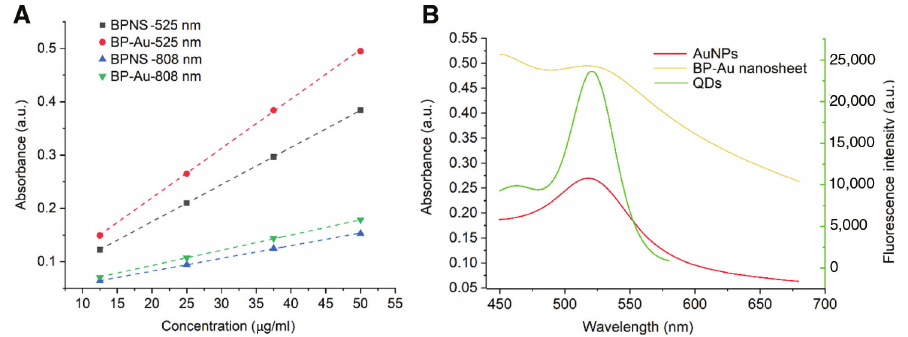
Figure 3: Feasibility analysis of the black phosphorus (BP)-Au nanocomposite quenching probe. (A) A linear relationship between absorbance intensity (at 525 nm and 808 nm) and BPNS or BP-Au nanocomposite concentrations. (B) Visible-near-infrared (Vis-NIR) spectra of the BP-Au nanocomposite and gold nanoparticles (AuNPs), and the fluorescence spectra of quantum dots (QDs). (The left Y axis is for Vis-NIR spectra and the right Y axis is for fluorescence the emission spectrum of